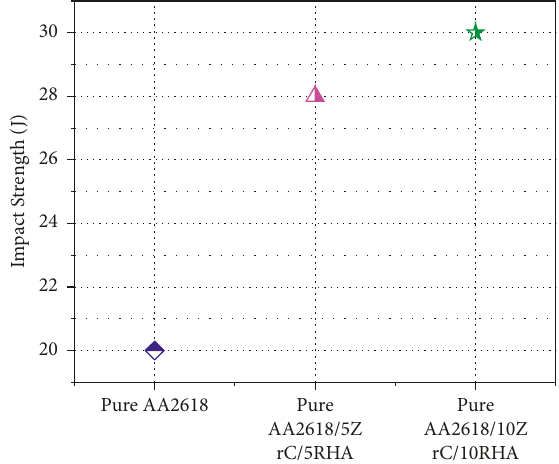
Figure 3: Effect on impact